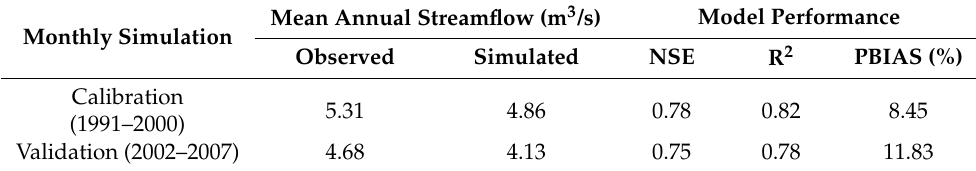
Table 4. Monthly measured and simulated streamflow calibration–validation